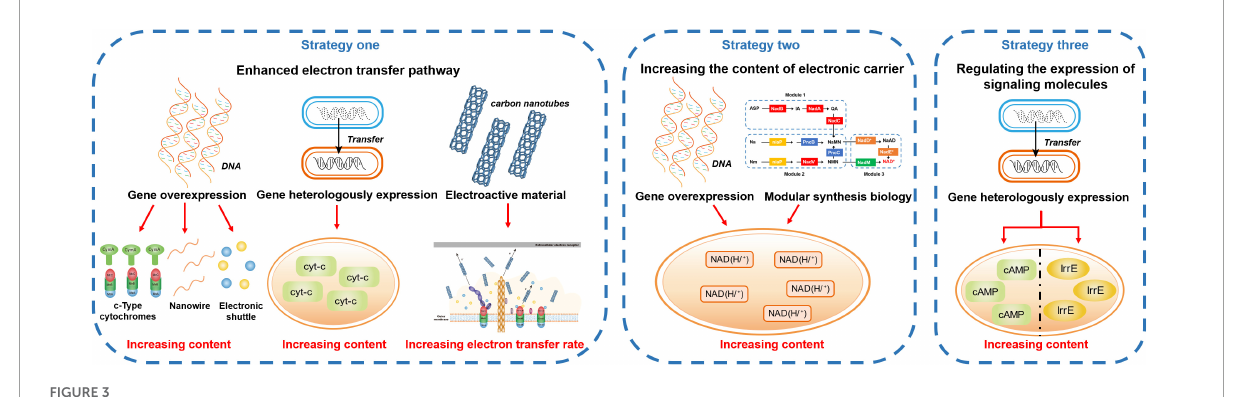
FIGURE3 Strengthening the extracellular detoxification